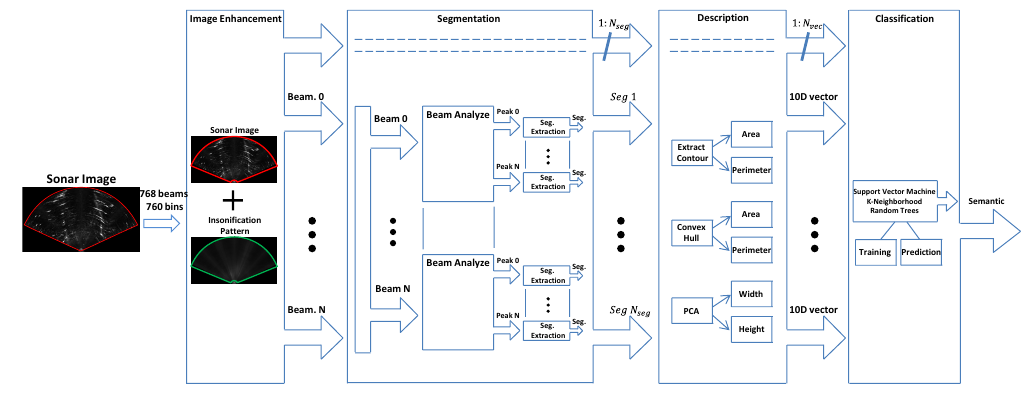
Figure 3. Overview of the proposed semantic